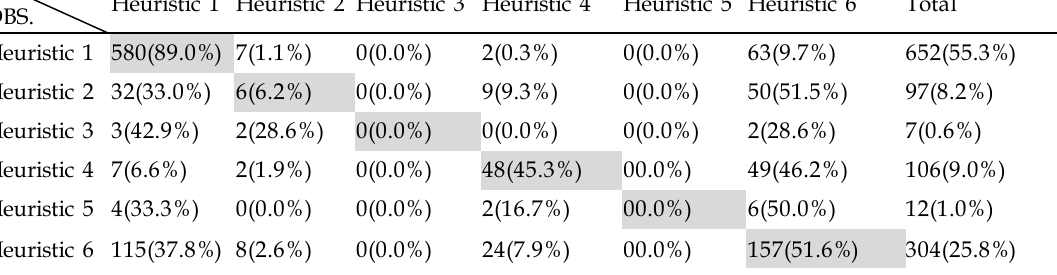
Table 12. Average confusion Matrix obtained by the random forest method using a 5-fold cross validation method